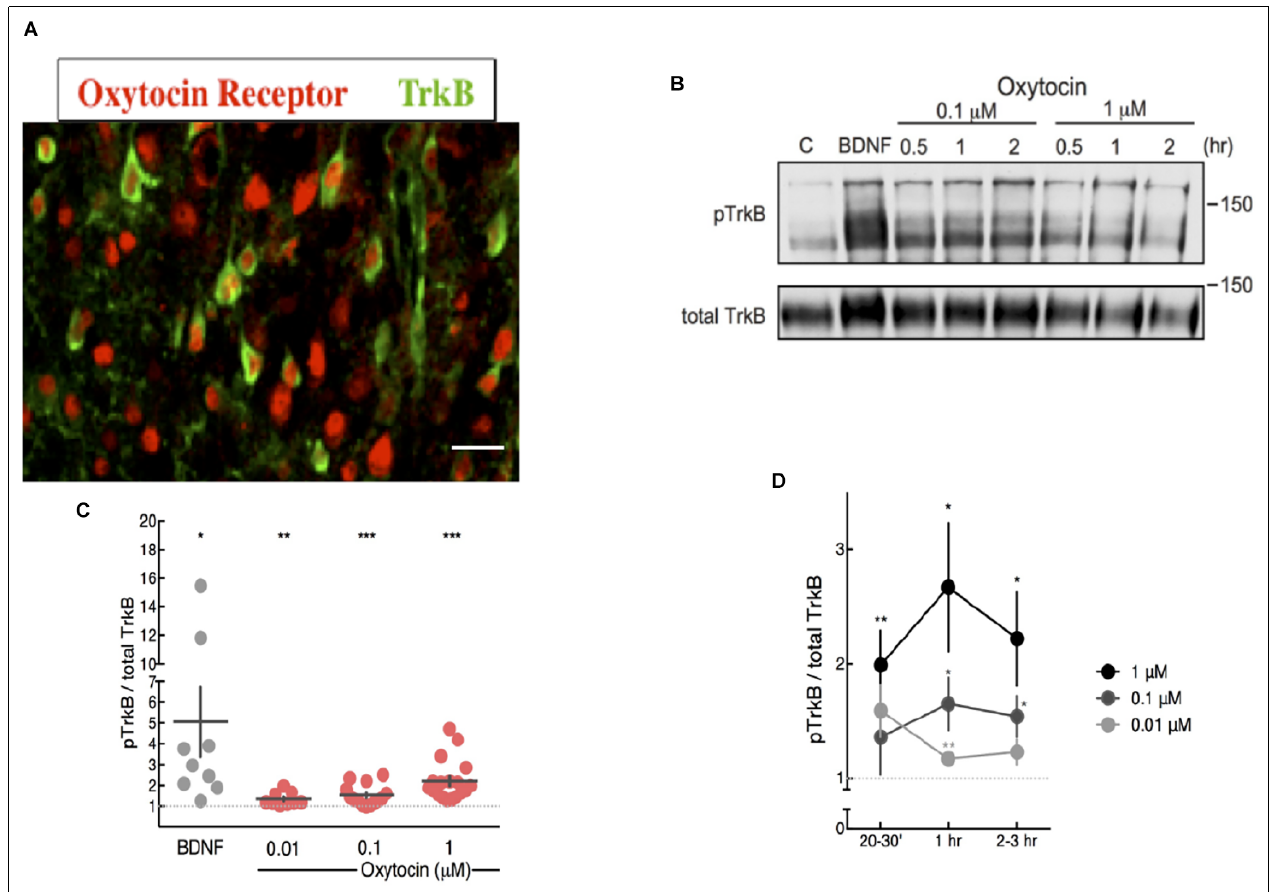
FIGURE 1 | Oxytocin ligand increased pTrkB level in primary cortical neurons detected by immunoblotting. (A) Expression of oxytocin and TrkB receptors in cortical neurons of 2 week mice. Each receptor was probed with specific antibodies for oxytocin receptor, red (Mitre et al., 2016) and TrkB, green (Bath et al., 2008). The BD transduction 610102 antibody was used to detect TrkB. Potential staining of OXTR in the nucleus of some cells can be visualized, which has been previously reported (Kinsey et al., 2007). (B) Oxytocin induces activation of TrkB receptors in primary cortical neurons, assessed by western blot with anti-pTrkB (Chao lab) and TrkB antibodies (R & D AF1494) BDNF is a positive control. (C,D) Time course and dose-response plot of quantitative analysis of densitometric immunoblot scans from 11 independent experiments, with oxytocin treatments of 0.01, 0.1 and 1 mM for 20–30 min. The pTrkB/total TrkB ratio was calculated by taking the ratio of the pTrkB densitometric signal over the total TrkB densitometric signal for each sample and then represented as a value relative to untreated control (BDNF: 6.95 ± 2.41 fold above control, N = 9, * p < 0.03; oxytocin 0.01 µ M: 1.34 ± 0.10, N = 9, ** p < 0.006; oxytocin 0.1 µ M: 1.53 ± 0.13, N = 16, *** p < 0.001; oxytocin 1 µ M: 2.22 ± 0.23, N = 18, *** p < 0.0001; oxytocin 10 µ M: 1.21 ± 0.03, N = 4, *** p < 0.0006). The p value (treatment vs. control) was determined with ANOVA test followed by post-hoc Tukey (* p < 0.05, ** p < 0.01). (D) Time course and dose-response plot of quantitative analyses of densitometric immunoblot scans from